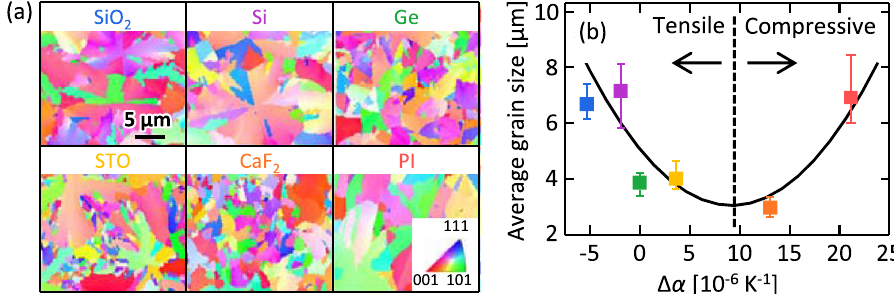
Figure 4. Grain sizes of the Ge layers on various substrates. ( a ) IPF images of the Ge layers, where the colors indicate the crystal orientations, according to the inset color scheme. ( b ) Average grain size determined by the EBSD analysis as a function of Δ α . The error bars indicate the variability in the EBSD measurements at four locations for each 1-cm square sample.